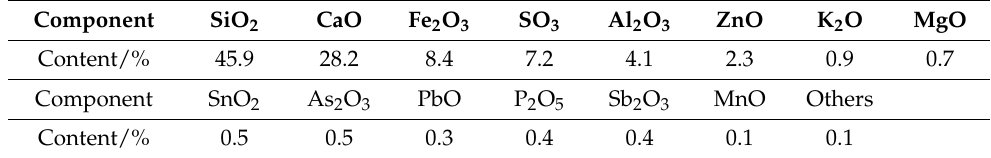
Table 1. Chemical components of Tongkeng ore.